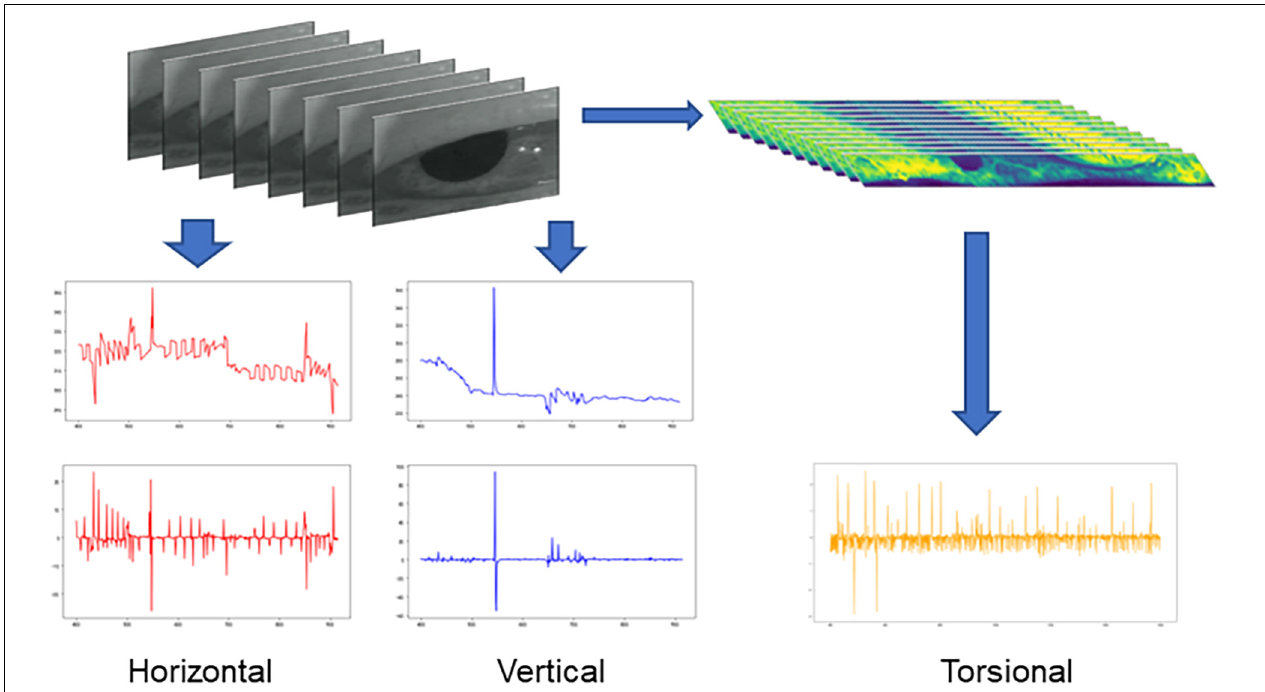
FIGURE 4 | Eye movement data generation. Each video was transformed to eye movement velocity in three dimensions. Horizontal and vertical velocity: coordinates of the pupil centre. Torsional velocity: the shift between two consecutive